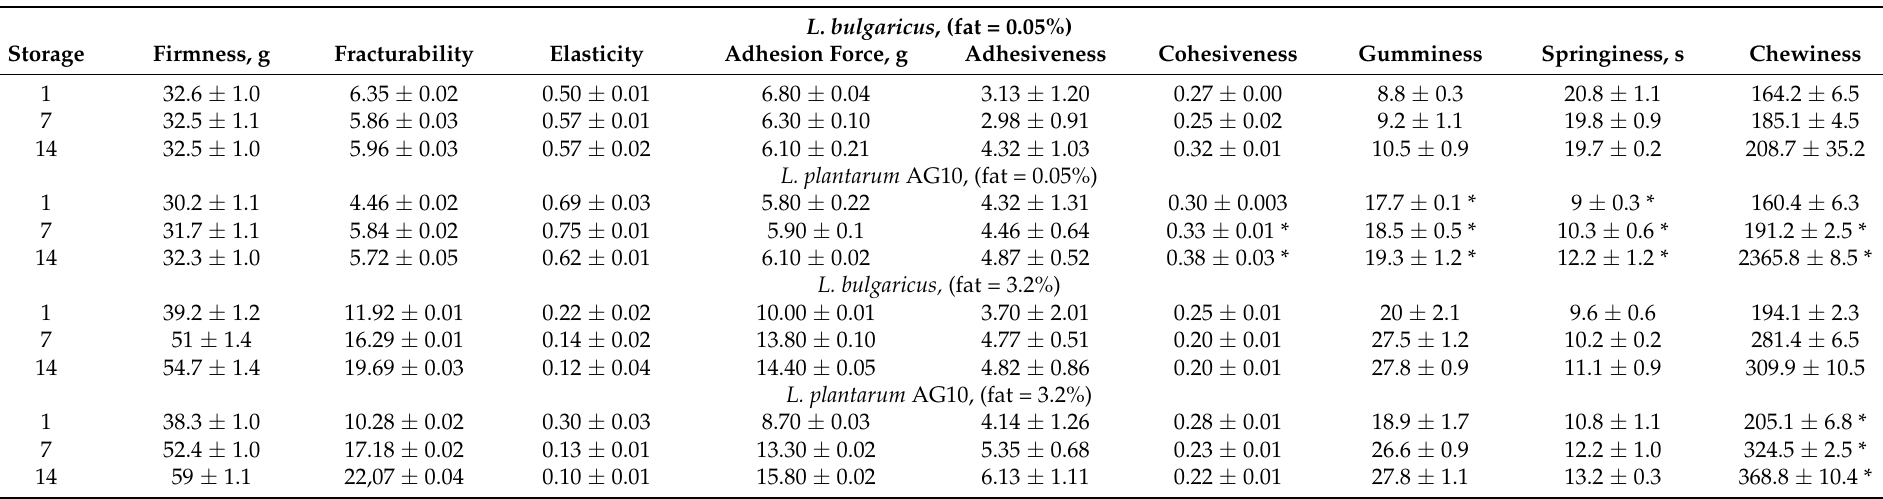
Table 2. Textural profile of skimmed and whole milk fermented with either L . bulgaricus (shown in white) or L . plantarum AG10 (shown in gray) after 1, 7, and 14 days of storage. Asterisks show a significant difference at p < 0.05. Mean values ± SD are shown (n = 3). L. bulgaricus , (fat =